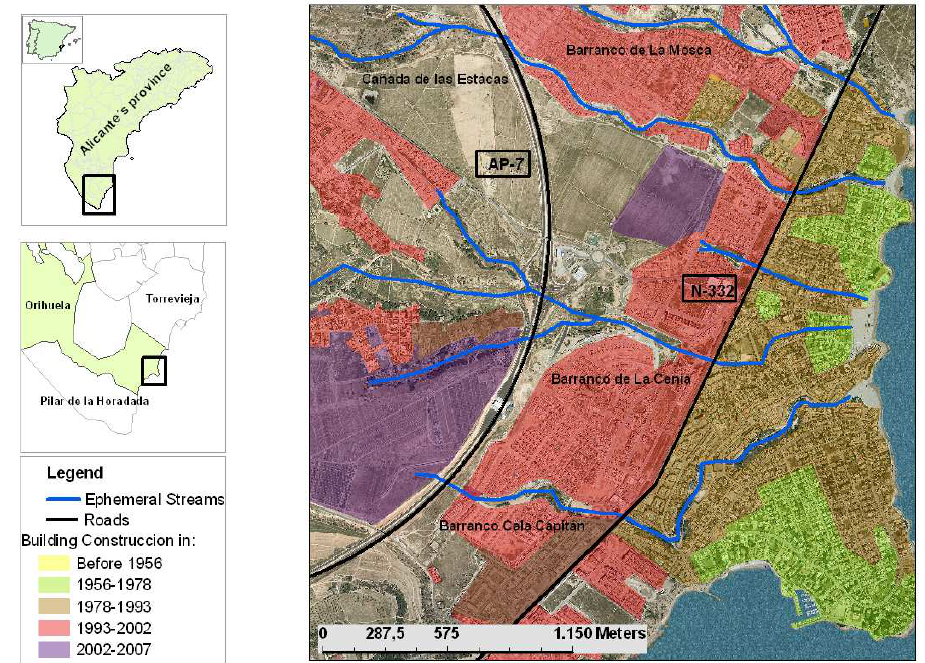
Fig. 2. Urban sprawl on the south coast of Orihuela.